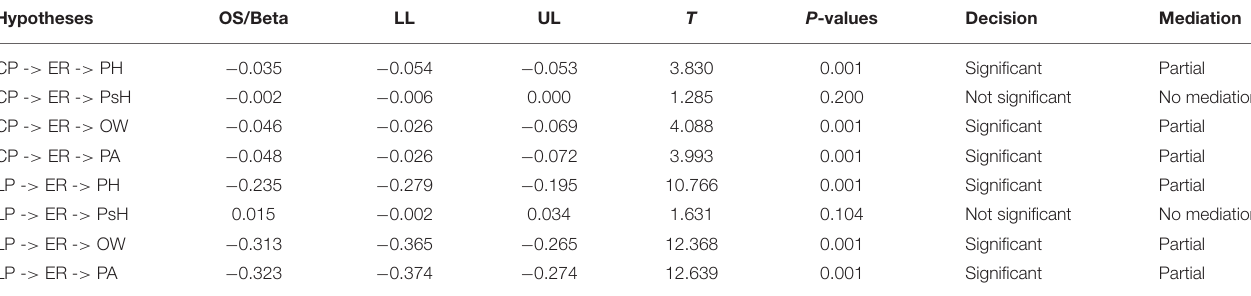
TABLE 7 | Mediation (indirect effect) result ( N =